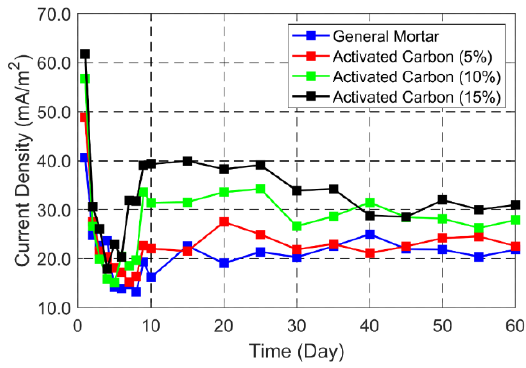
Figure 10. Current density variations for 60 days.